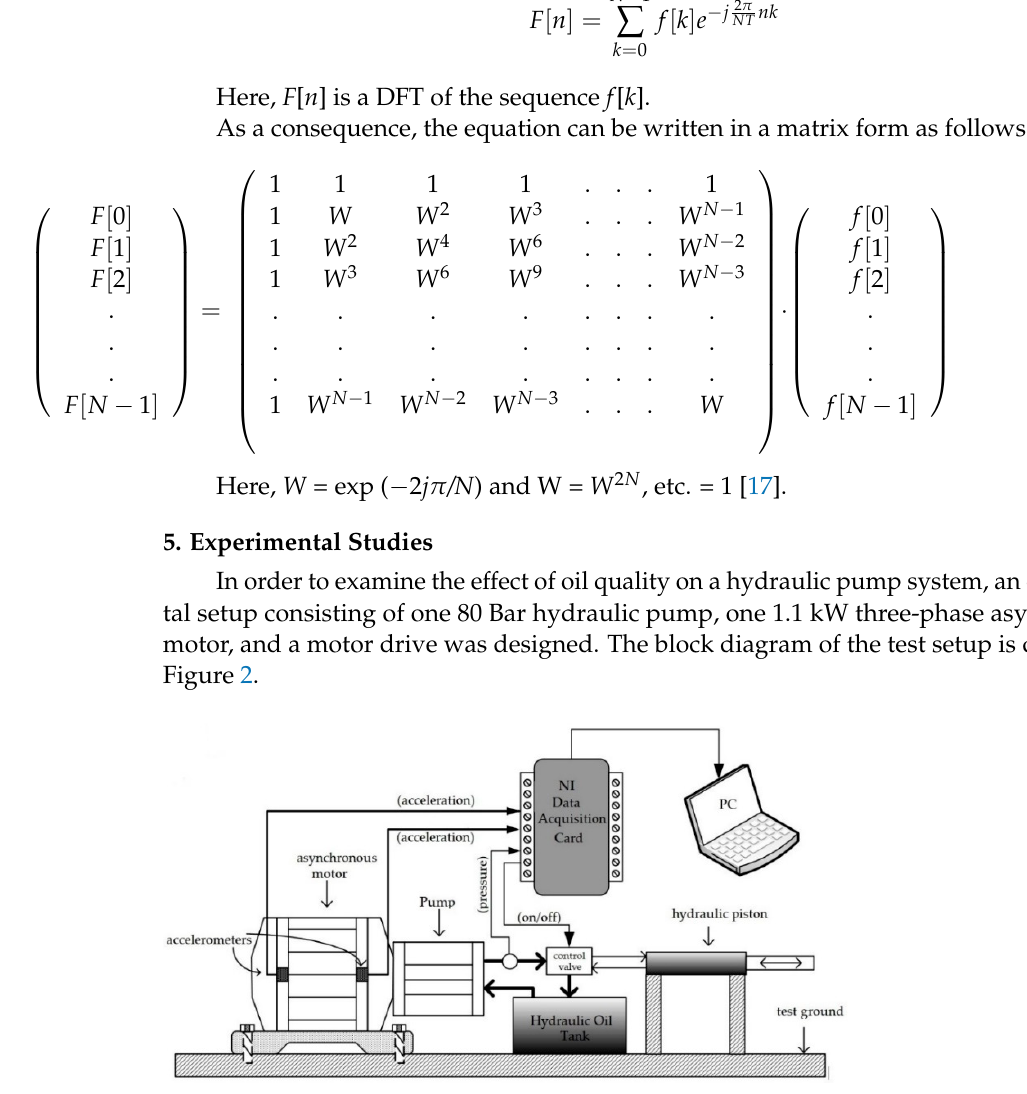
Figure 2. Experimental setup to examine the effect of oil quality on a hydraulic pump system.